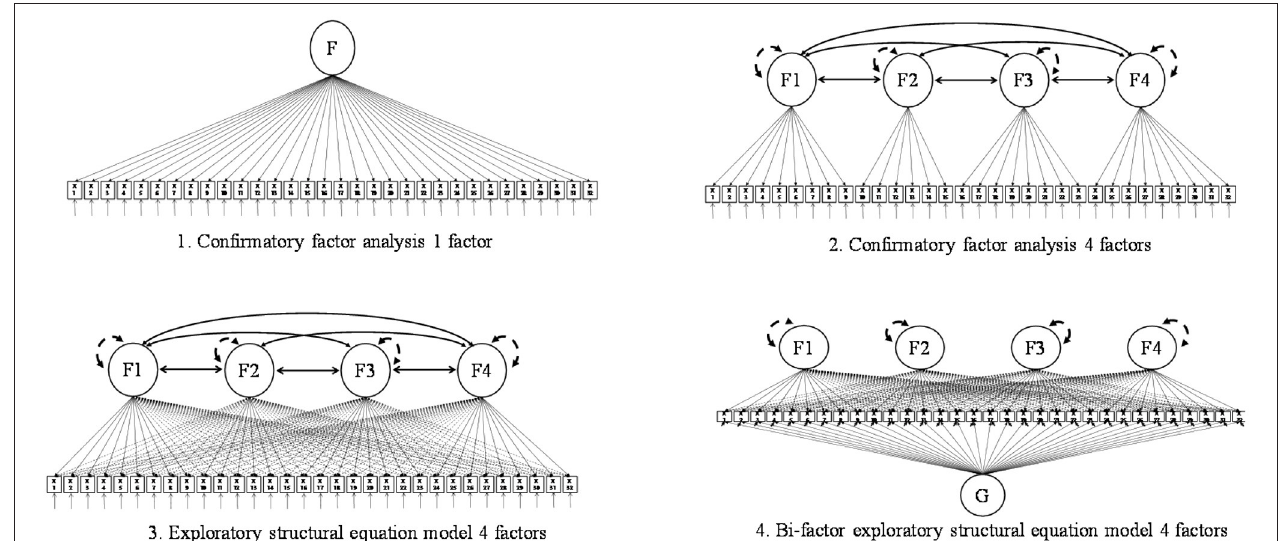
FIGURE 1 | Proposed structural factors of the model tested.